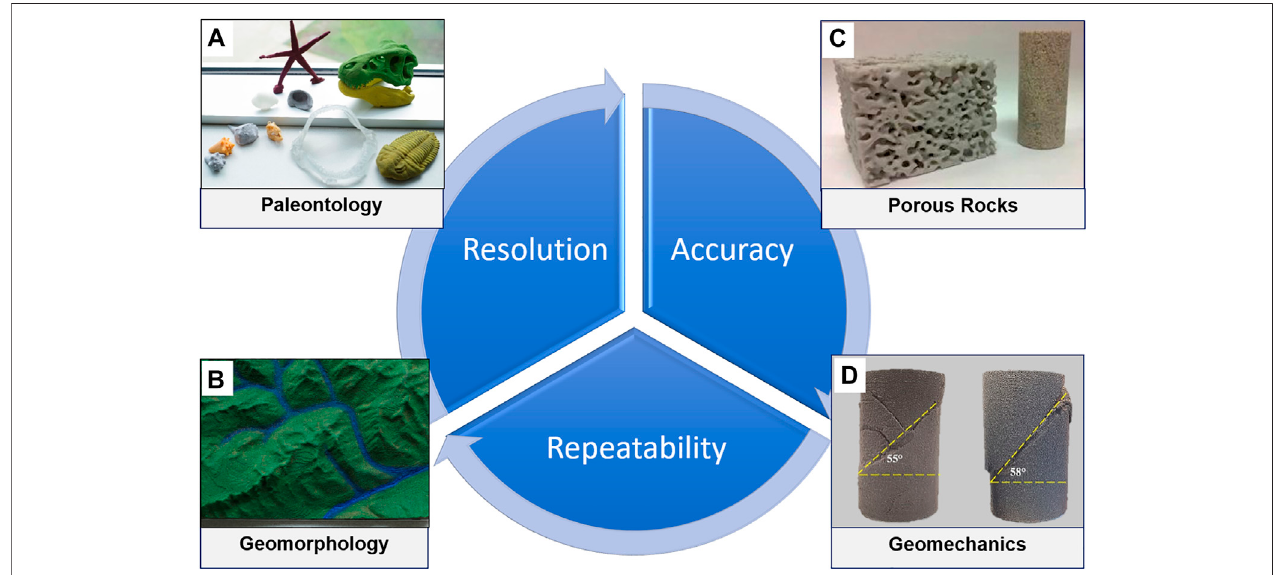
FIGURE 2 | Applications of 3D printing in the geoscience research areas: (A) paleontology, (B) geomorphology, (C) porous rocks, and (D) geomechanics. A blue chart indicates the characteristics of 3D-printed models that are critical for each of the geoscience areas. Materials used in a speci fi c application have different physical and chemical properties, which affect theresolution ofa 3D-printed model. 3D printer ’ s hardware and post-processing of3D-printed models determine the accuracy of external and internal features. A combination of the three previous characteristics affects the repeatability of a digital design 3D-printed in multiple copies.